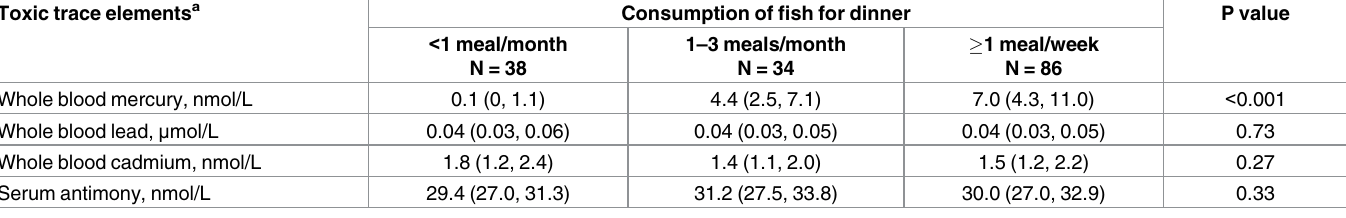
Table 4. Levels of toxic trace elements according to fish intake in healthy never-pregnant women (n = 158). Toxic trace elements